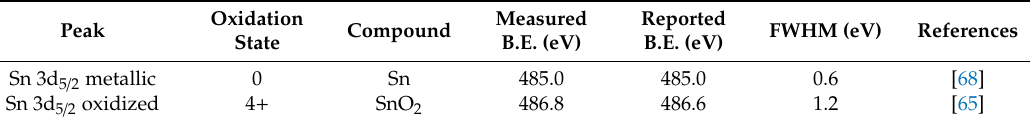
Figure 13. Sn 3d 5/2 narrow scan, Sn sample. Table 11. B.E. values for Sn (with reference the C1s peak due to adventitious C which is observed at 285.0 eV).